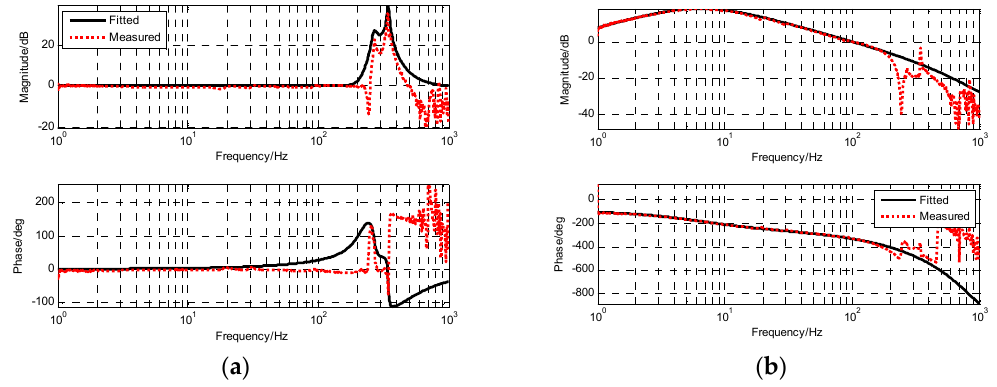
Figure 16. The frequency characteristics of OTT based on MEMS gyro: ( a ) The resonance response of platform; ( b ) the open-loop frequency response of platform.